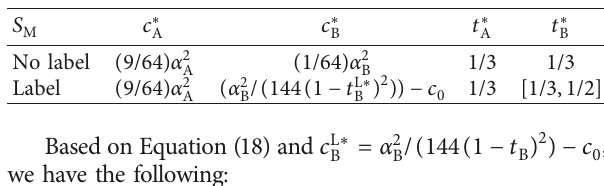
Figure 8: Income range of supplier in ASM. Table 5: Optimal decisions of players in